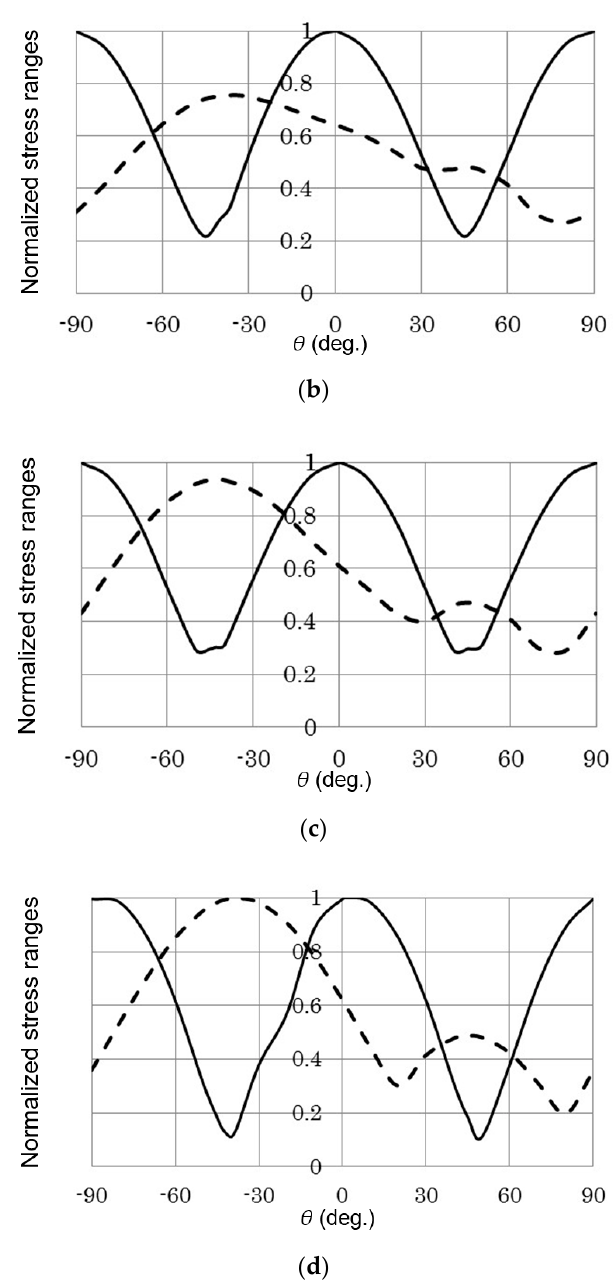
Figure 19. Shear stress range and normal stress range at each angle θ for the case of RP steel ( Δ K III / Δ K I = 1.5, R I = 0.05, R III = − 1). ( a ) δ = 30°, ( b ) δ = 90°, ( c ) δ = 120°, and ( d ) δ = 180°.